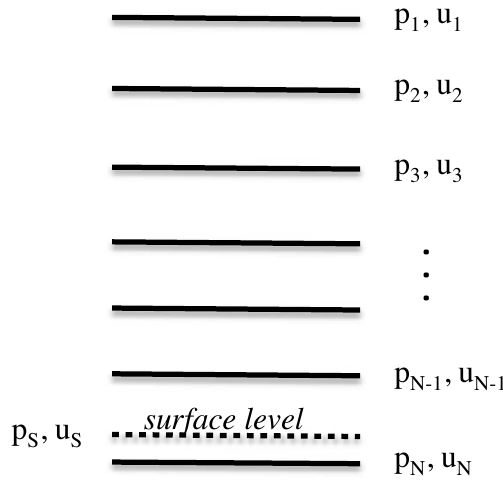
Fig. A1. The standard, pre-defined pressure levels are given by p i , i =1 ... N . At each level i there is a corresponding value of retrieved CO 2 volume mixing ratio given by u i . The dotted line represents the surface